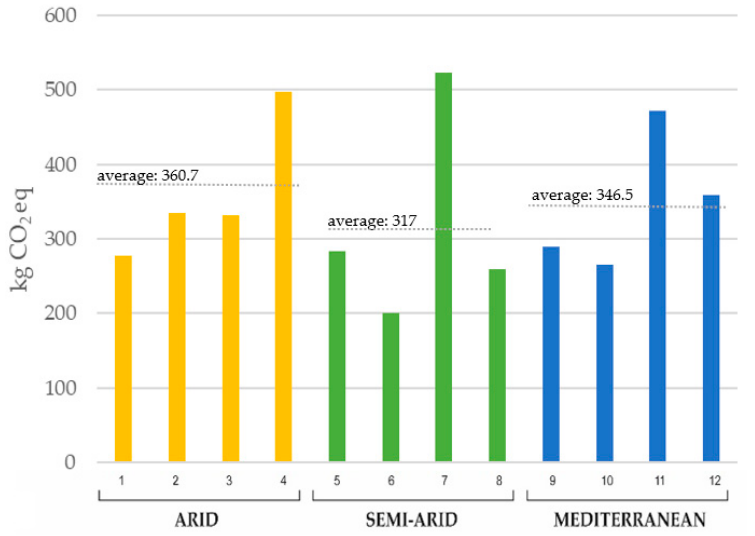
Figure 5. kg of CO 2 eq emitted from a ton of grapes of each vineyard according to the analyzed climatic regions .